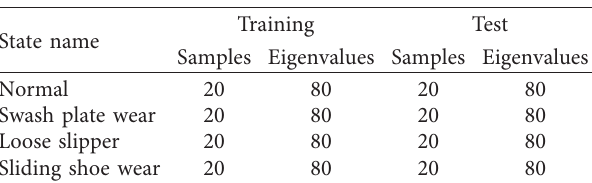
Table 5: The numbers of samples contained in the training set and test set.